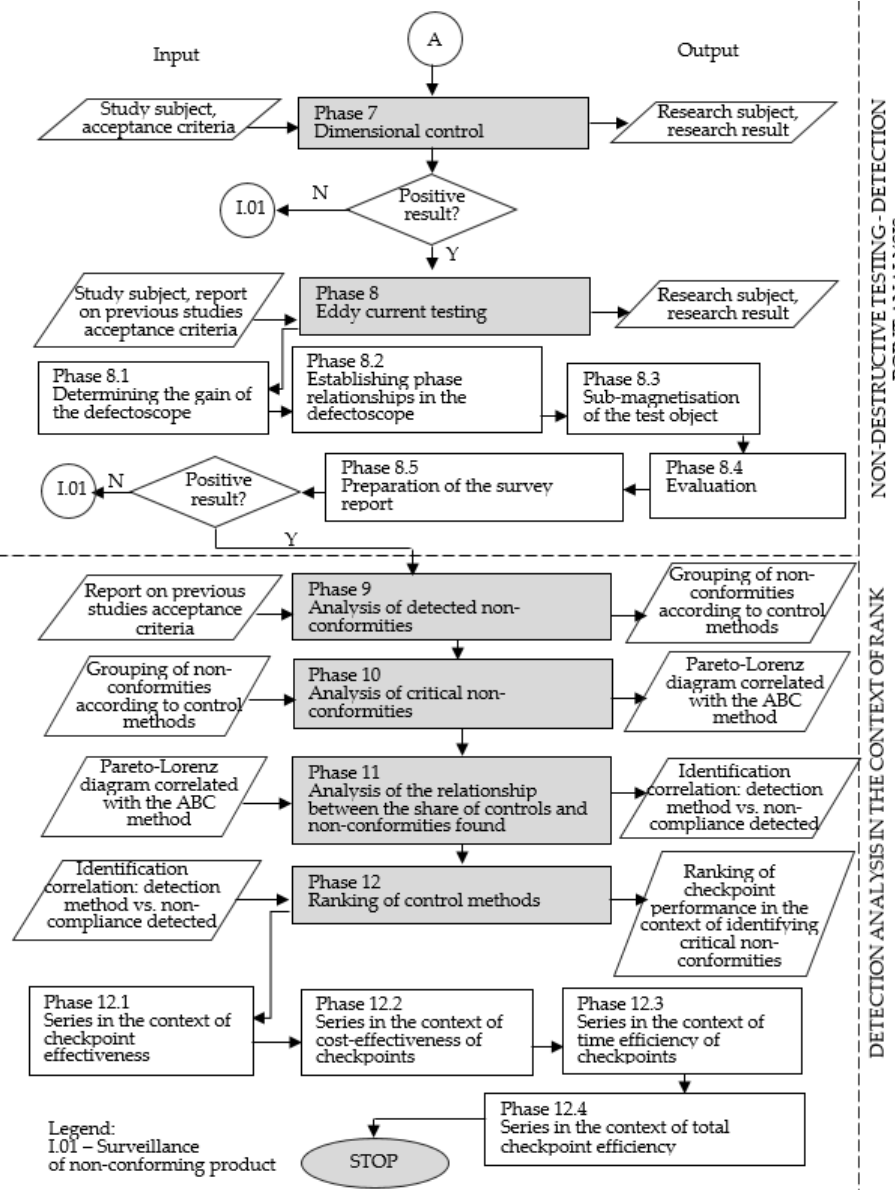
Figure 3. Rank model of casting non -conformity detection methods—part 2. Own development.